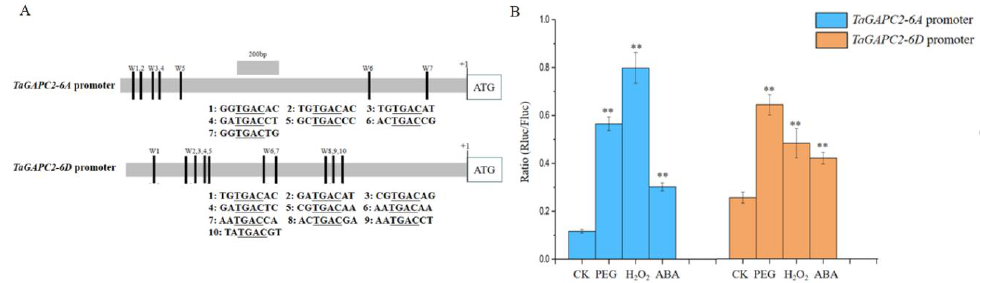
Figure 2. The TaGApC2 promoter in C hinese spring wheat responds to abiotic stress in tobacco. ( A ) Schematic diagram of the distribution of the W-boxes in the TaGApC2 promoter. ( B ) The Rluc/Fluc enzyme activity suggested that TaGApC2 promoters are stress-inducible. The data represent three independent experiments. The standard deviation (SD) is indicated at each point. Significant differences were assessed by one-sided paired t -tests (** p < 0.01).